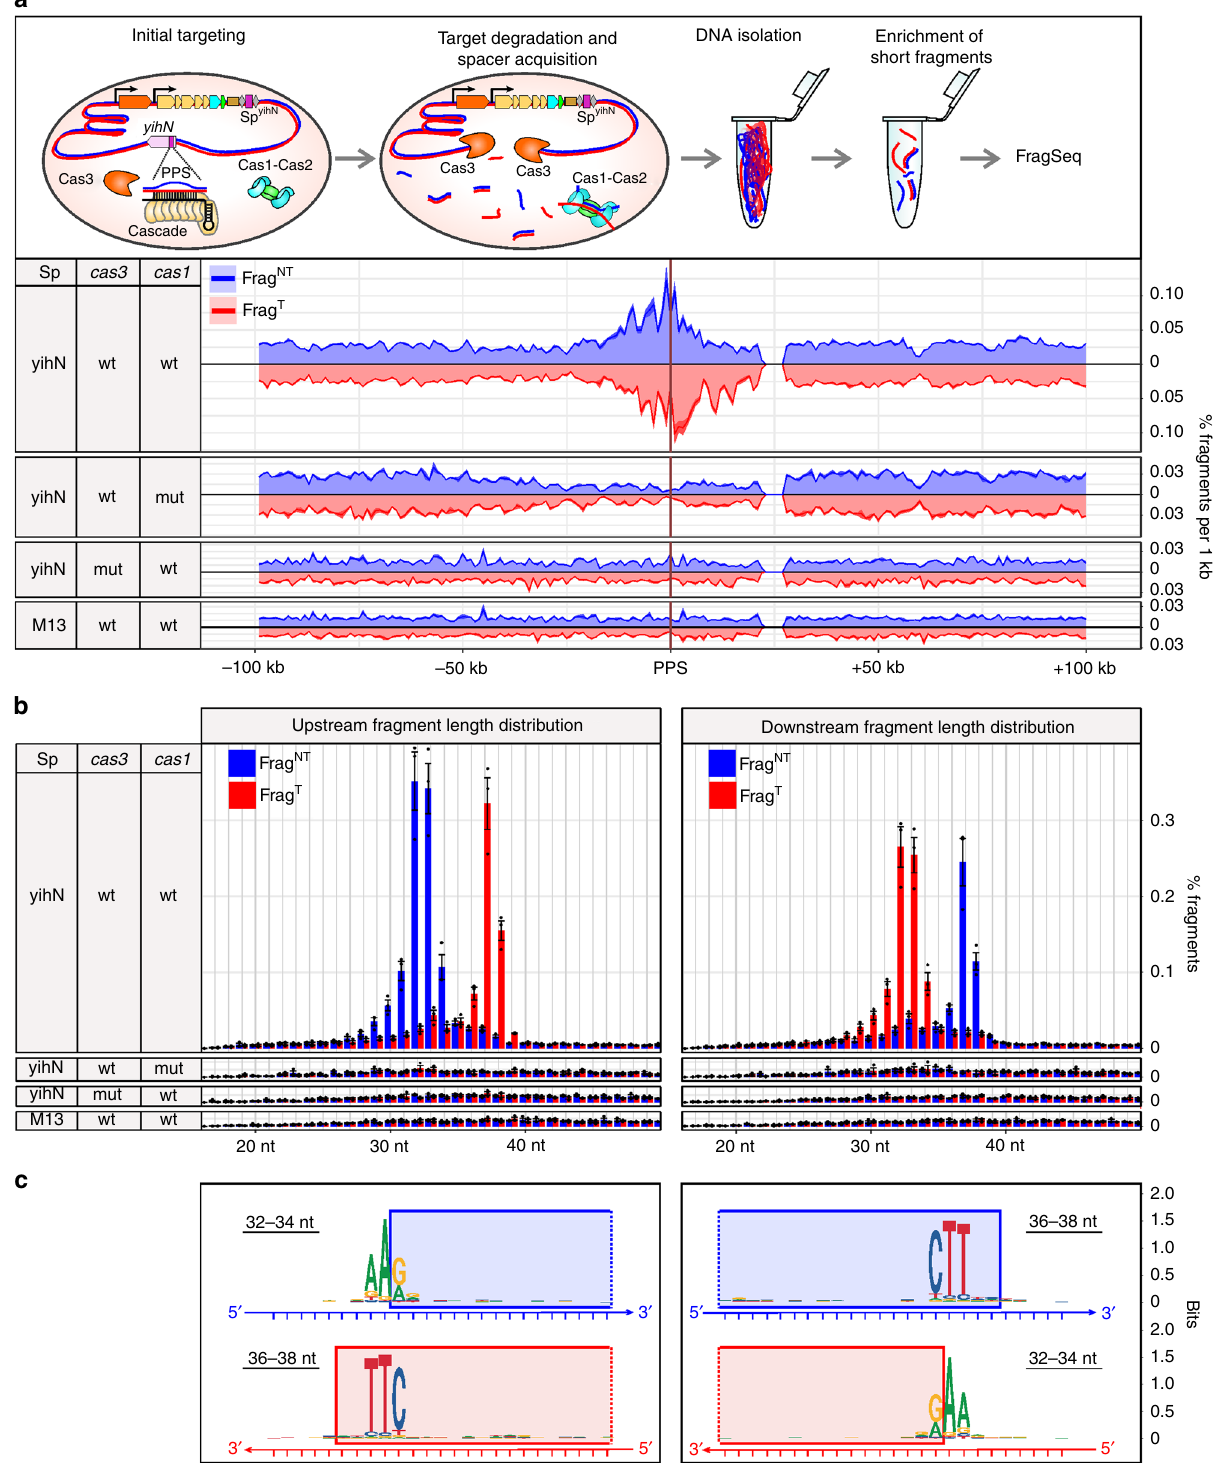
Fig. 2 FragSeq detection of DNA fragments in cells with the type I-E self-targeting system. a Effect of self-targeting on PPS-region DNA fragment distributions. Top, events occurring in cells upon induction of cas gene expression. Bottom, FragSeq results. Coverage plots show mean of three biological replicates. Blue, nontarget-strand-derived fragments (Frag NT ); red, target-strand-derived fragments (Frag T ). b Length distributions of PPS-region-derived fragments (mean ± SEM of three biological replicates). c Sequence alignments of genomic DNA from which PPS-region fragments are derived. Blue rectangles, sequences present in Frag NT ; red rectangles, sequences present in Frag T . Source data are provided as a Source Data fi